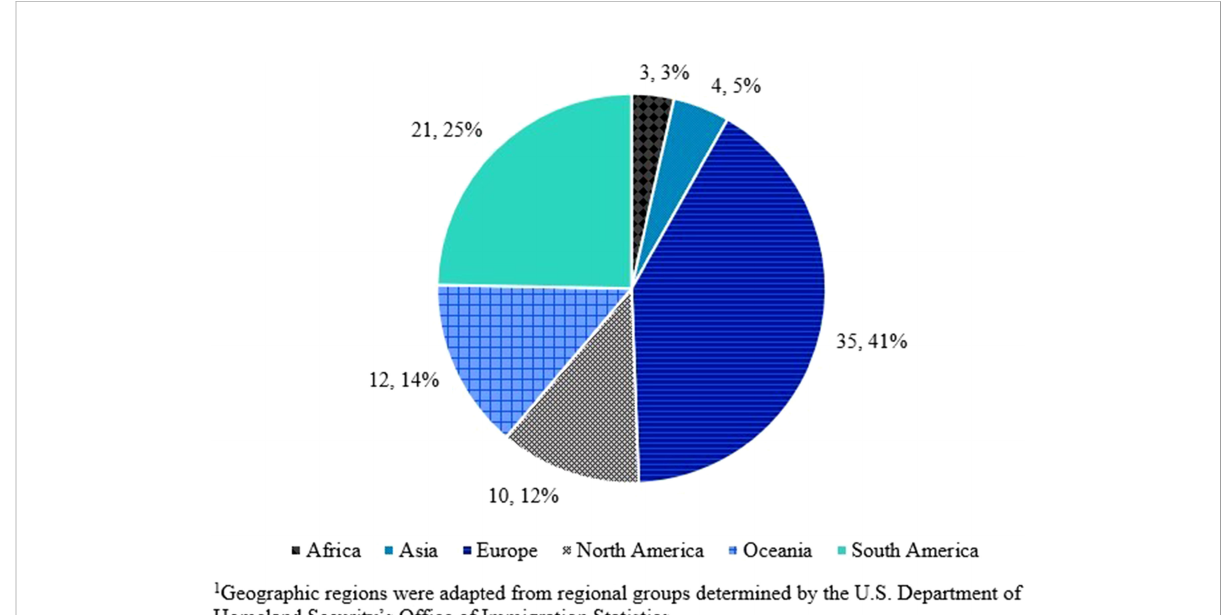
FIGURE 2 Number of studies by geographic region 1 ( n =85). Results are reported as ( n ,